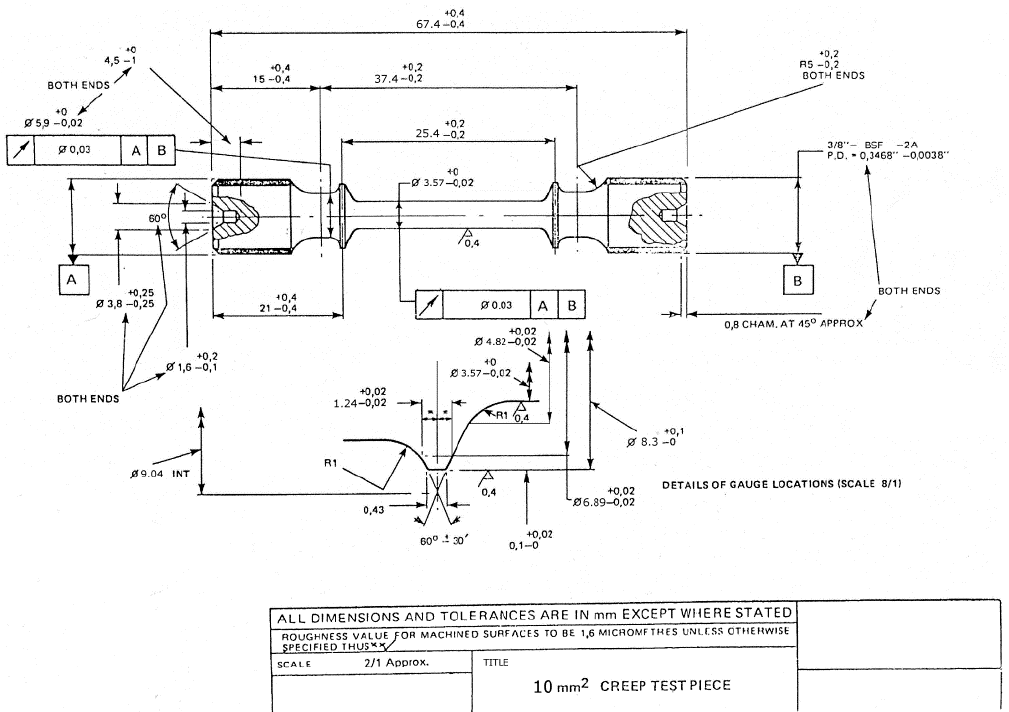
Figure 1. Creep specimen design.